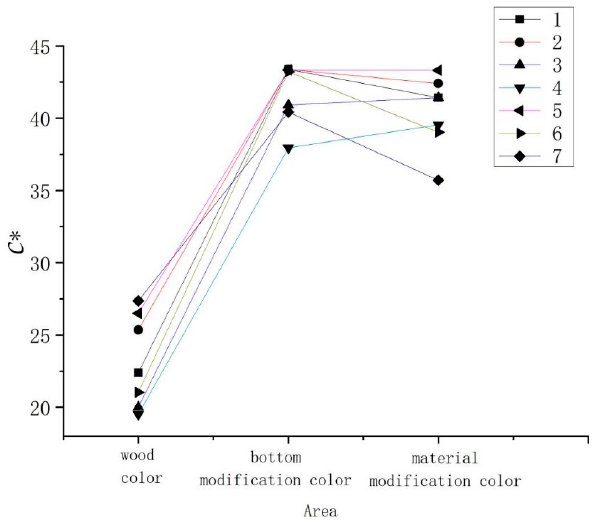
Figure 4. Sample color saturation.